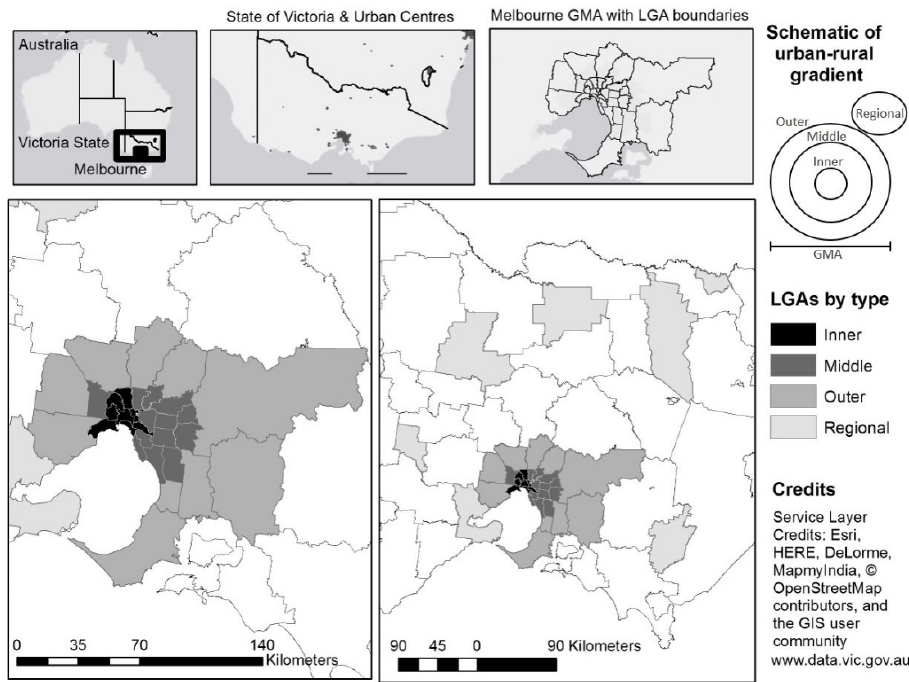
Figure 1. Local governments in the state of Victoria by type (inner, middle, outer, and regional), indicating local governments in and surrounding the Greater Metropolitan Area (GMA) of Melbourne, Australia.